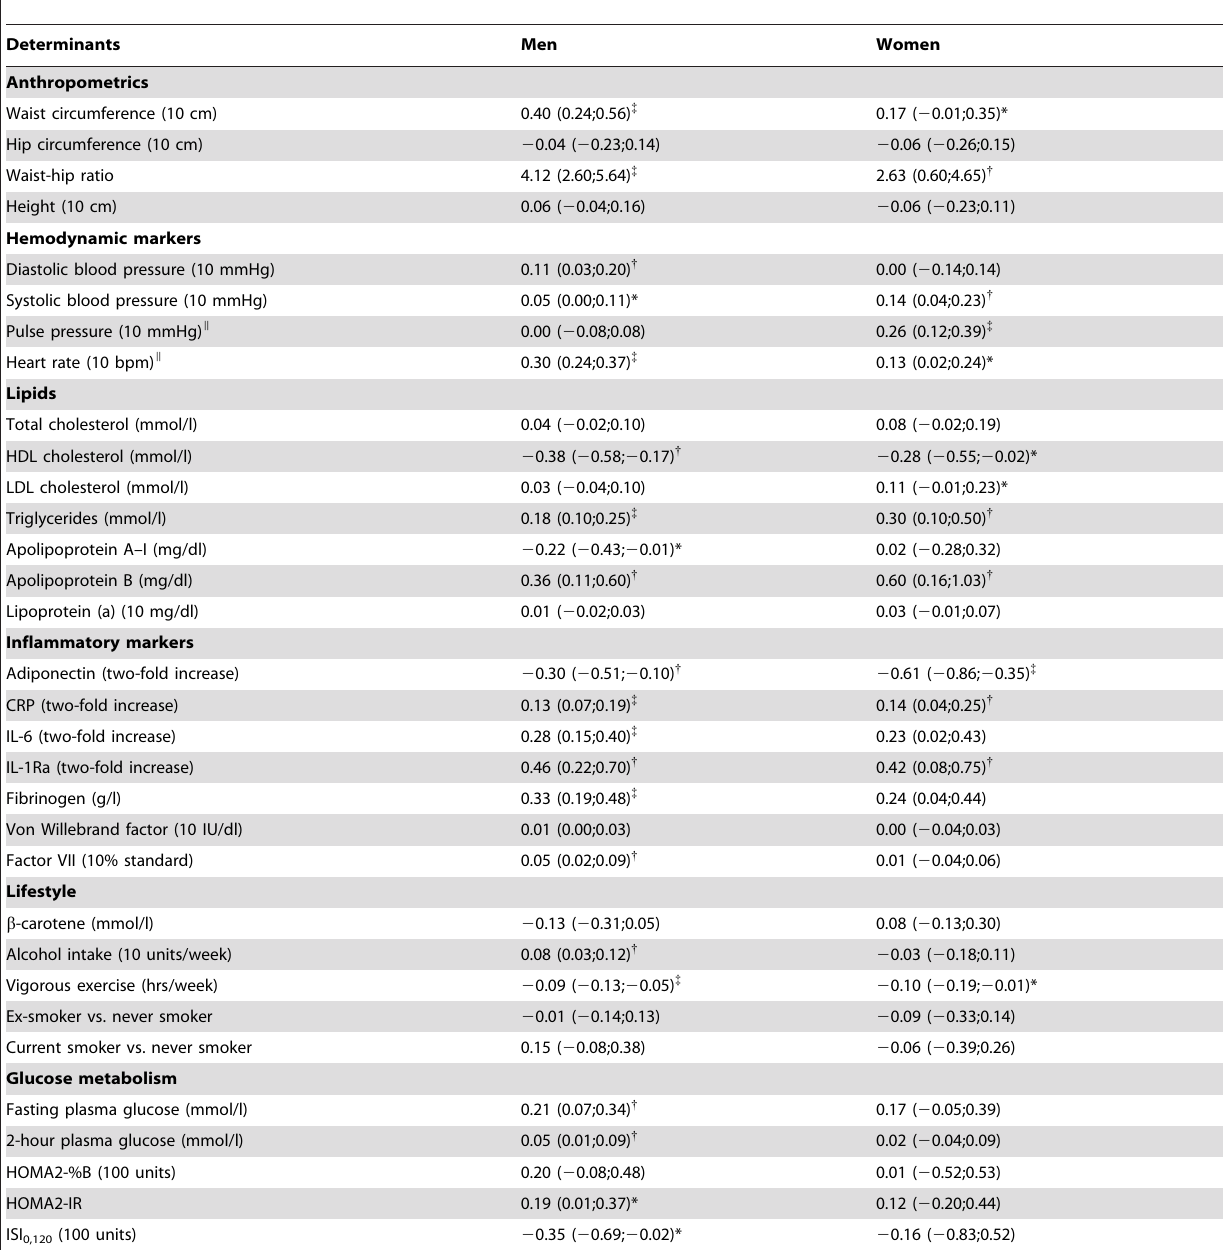
Table 2. Difference (95%-CI) in aortic pulse wave velocity at follow-up by a unit difference in baseline determinants.